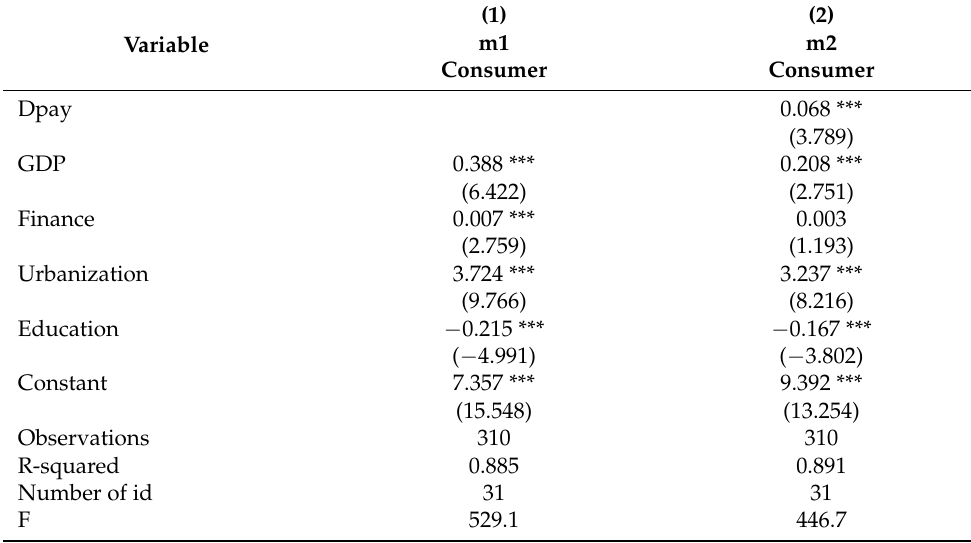
Table 10. Robustness analysis: sample tailing